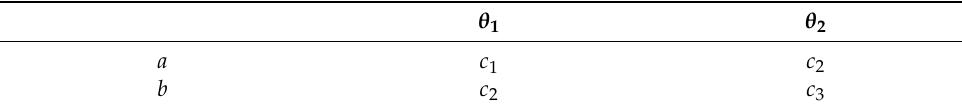
Table 1. Monetary consequences of signing players.